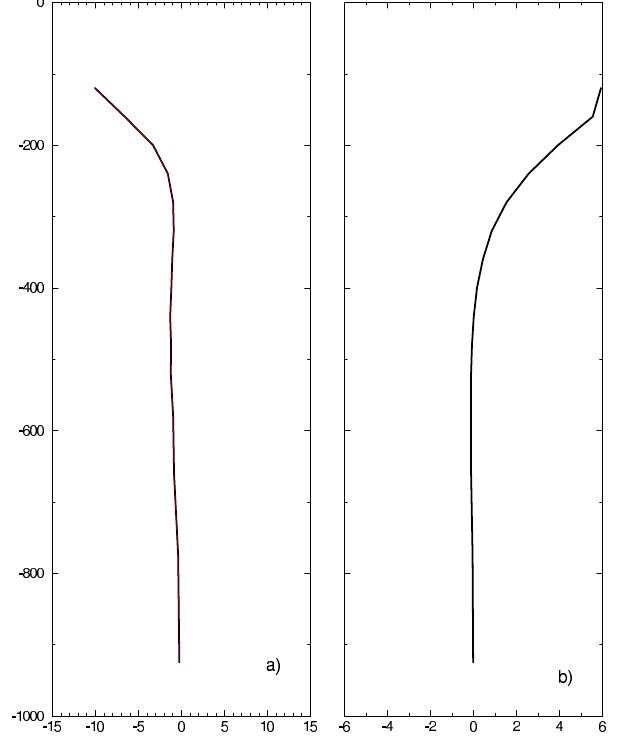
Fig. 2. Bivariate Empirical Orthogonal Functions used in assimila- tion of SLA: (a) Temperature EOF, (b) Salinity EOF.